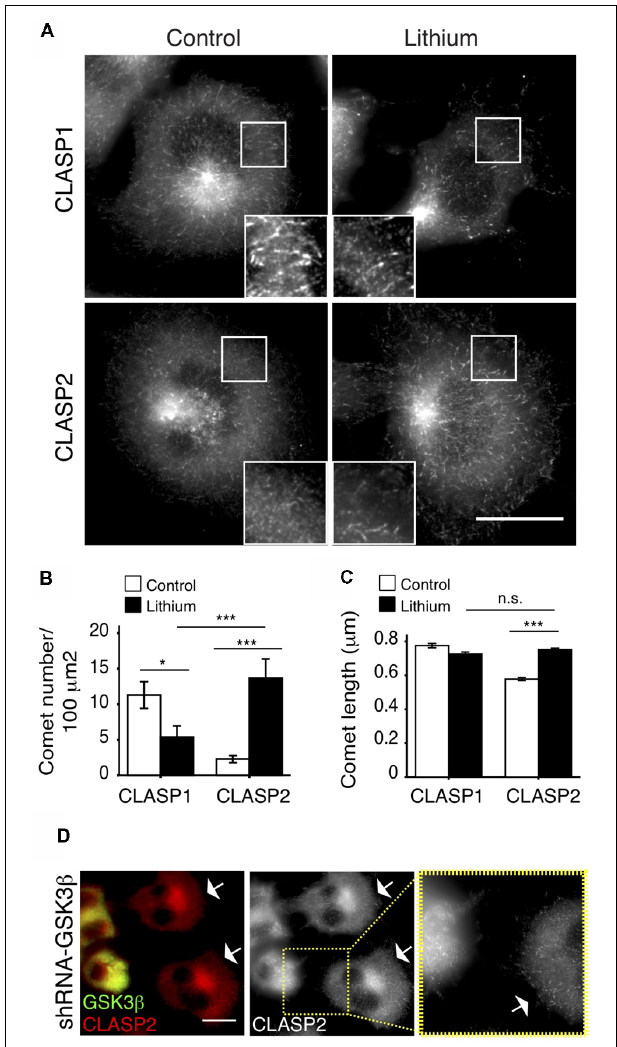
FIGURE 2 | Differential regulation of CLASP1 and -2 by glycogen synthase kinase 3 (GSK3). (A) CLASP distribution in control N1E-115 cells and cells treated with lithium chloride (LiCl; Lithium), a well-known GSK3 inhibitor. Serum-starved N1E-115 cells were treated with Lithium (20 mM), along with myo-inositol (10 mM), for 4 h, fixed and stained with antibodies against CLASP1 (upper panels) or CLASP2 (lower panels). The control cells shown were treated with sodium chloride (20 mM) and myo-inositol (10 mM) for 4 h. Scale bar = 20 µ m. (B) Quantification of CLASP1 and -2 comet density (number of comets/100 µ m 2 ) and (C) comet length (in µ m). Comets were counted in 3–4 squares of 100 µ m 2 per cell. CLASP1: Control: 699; Lithium: 869. CLASP2: Control: 962; Lithium: 1610. Control vs. Lithium treatment was compared for each CLASP. Also, CLASP1 and CLASP2 comet density and lengths were compared after Lithium treatment in (B,C) . ANOVA tests were performed. SEM was depicted in each bar graph. (D) CLASP2 localization in N1E-115 cells upon GSK3 β knockdown by shRNA, in comparison with control (non-transfected) cells. Cells were transfected with shRNA-GSK3 β , fixed 72 h later and stained with antibodies against GSK3 (green in merge) and CLASP2 (red in merge). White arrows point to non-transfected cells. Scale bar = 20 µ m. Inset shows detailed CLASP2 pattern in control and GSK3 knockdown